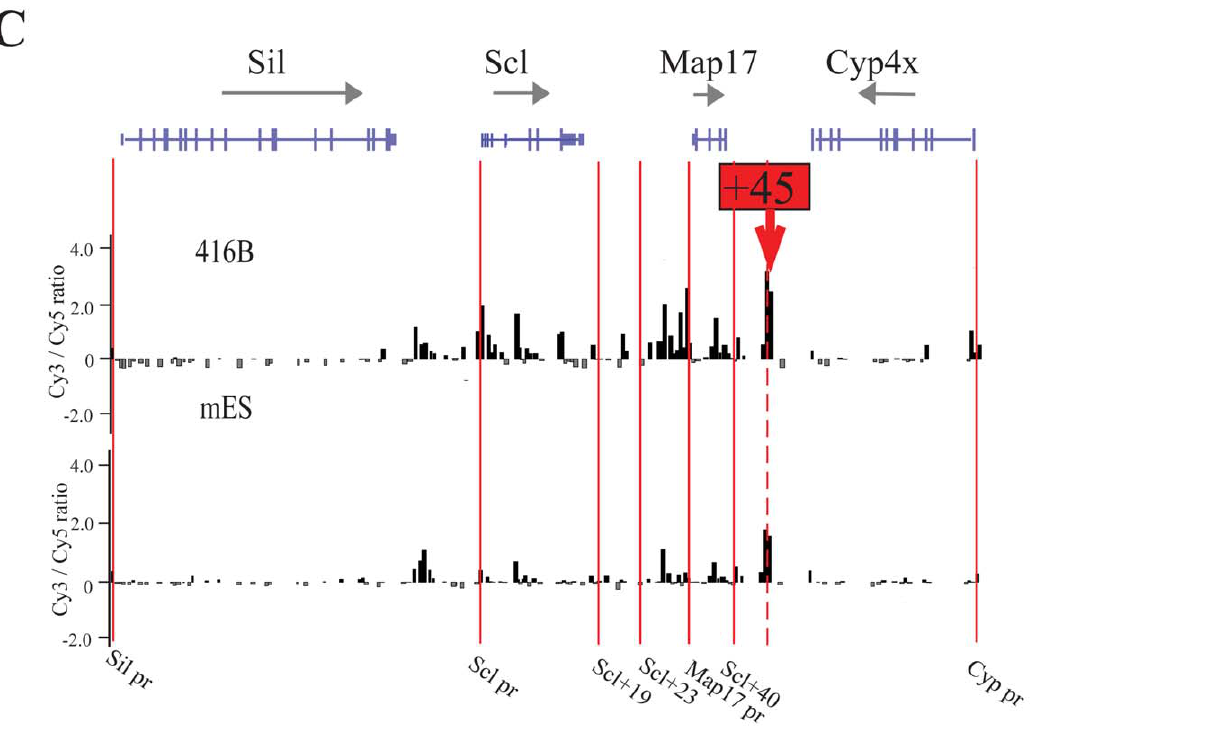
Figure 3. Invivo binding of CTCF to 57FPR sequence in haematopoietic progenitor cells. ( A ) DMS footprinting of the 350 base pair core region of the + 45 element in 3 cell types, BW5147, 416B and mouse ES cells, shows a DNA protein footprint that extends to 57 base pairs in length. Open circles represent relative protection from DMS-induced methylation compared with naked genomic DNA control, while the closed circle represents enhancement of DMS-induced methylation. Multiple lanes correspond to different biological replicates. The sequence of the 57 bp footprinted region (57FPR) is shown with cross-species sequence comparison. The CTCF-consensus binding site from Xie et al is also represented. ( B ) EMSA demonstrating a direct interaction between the 57FPR and CTCF protein (lane 2). The interaction is lost by competition with wild type 57FPR (lane 3), but not by CTCF-mutated 57FPR (lane 4). The arrow indicates the super shifted complex by co-incubation with specific anti-CTCF antibody (lane 5). The wild type and mutated sequence used for the EMSA are also shown. ( C ). ChIP-chip profiles mapping CTCF binding across 150 kb of the extended Scl locus in 2 cell types, 416B (mouse haematopoietic progenitor cells) and mouse embryonic stem cells (mES). The location of the 4 genes at the locus are represented at the top of the figure (Sil, Scl, Map17 and Cyp4x) with direction of transcription indicated by the arrows and translated